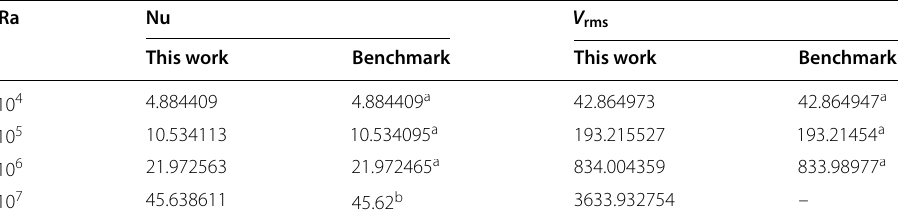
Table 2 Comparison of computed Nusselt number Nu and RMS velocity V rms with benchmark values from Blankenbach et al. [35] a and Koglin Jr et al. [36] b Ra